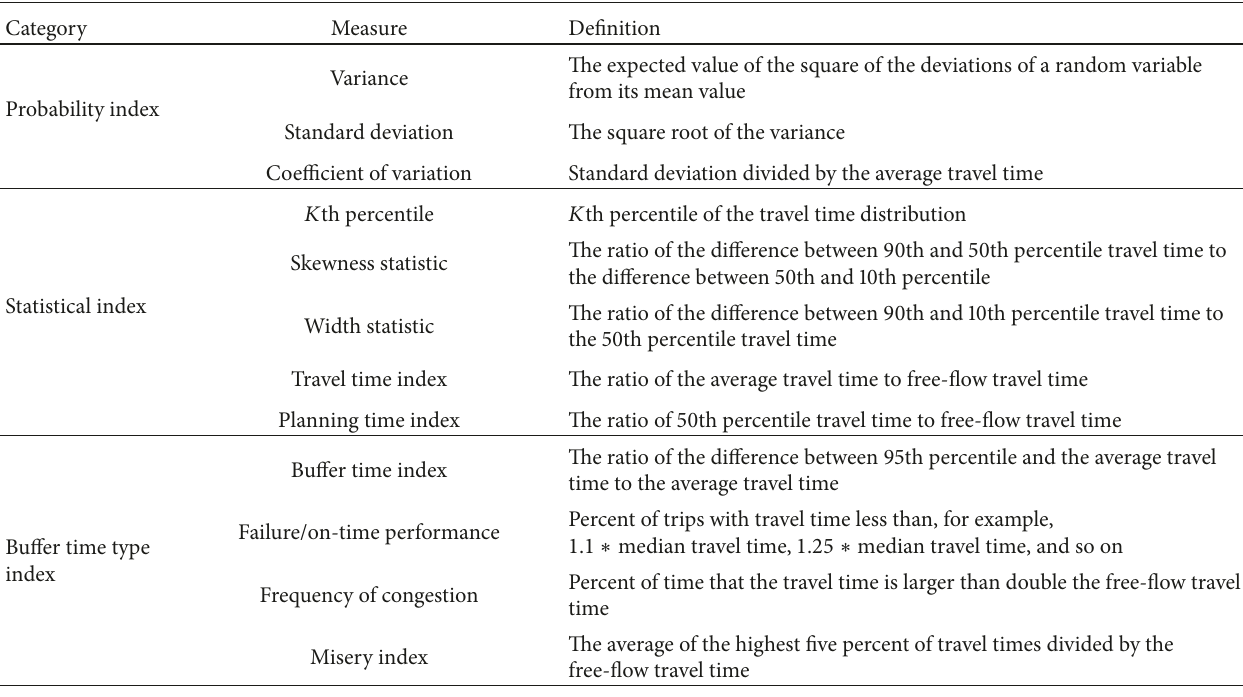
Table 1: Travel time reliability measures.